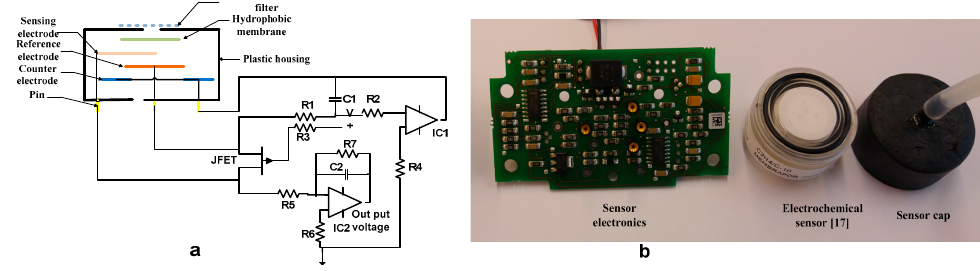
Figure 2. ( a ) Electrochemical sensor with sensor electronics; ( b ) Electrochemical gas sensor